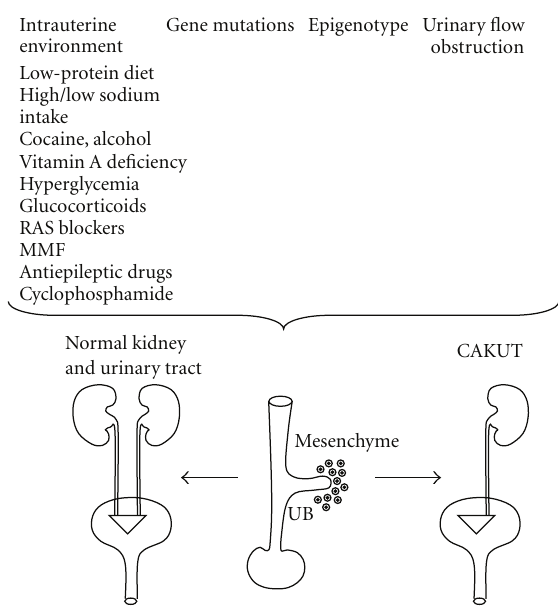
Figure 1: Schematic representation of the proposed impact of intrauterine environment, gene mutations, epigenotype, and uri- nary flow obstruction on the pathogenesis of CAKUT. These factors cause aberrant interactions among the mesenchyme, ureteric bud (UB), or bladder anlagen to result in CAKUT [102]. Please see text for